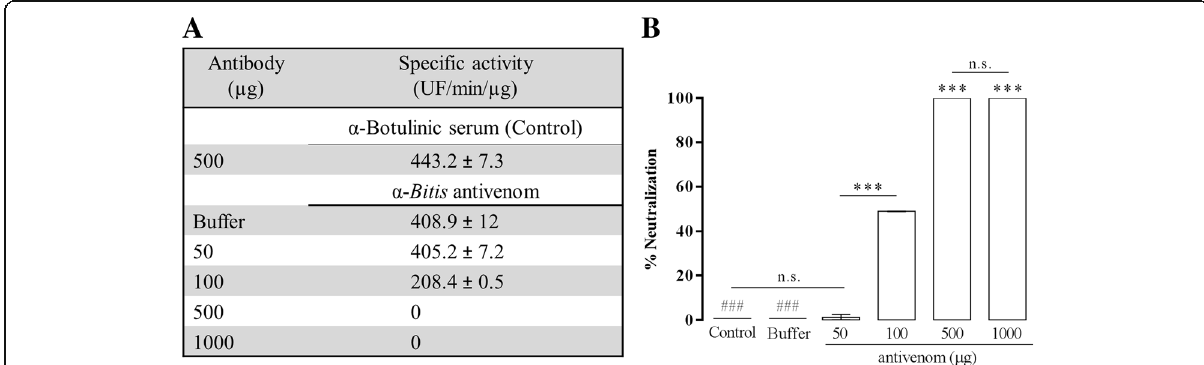
Fig. 4 Kn-Ba neutralization by specific antivenom produced by the Butantan Institute. a The inhibition of Kn-Ba proteolytic activity, pretreated or not with α -Botulinic serum and α - Bitis-arietans antivenom, was performed upon Abz-FRSSR-EDDnp FRET substrate. b The percentage of neutralization was carried out and the assays were carried out in quadruplicate. Results were expressed as specific activity (UF/min/ μ g)±SEM and analyzed statistically using One-Way ANOVA test followed by Tukey HSD post-hoc tests (* p <0.05). (*) differences between samples and (#) differences between samples and controls. The hydrolysis of substrate was monitored in the spectrophotometer FLUOstar® Omega (BMG Labtech, HE, Germany; λ EM 420nm and λ EX 320nm); n.s.=not